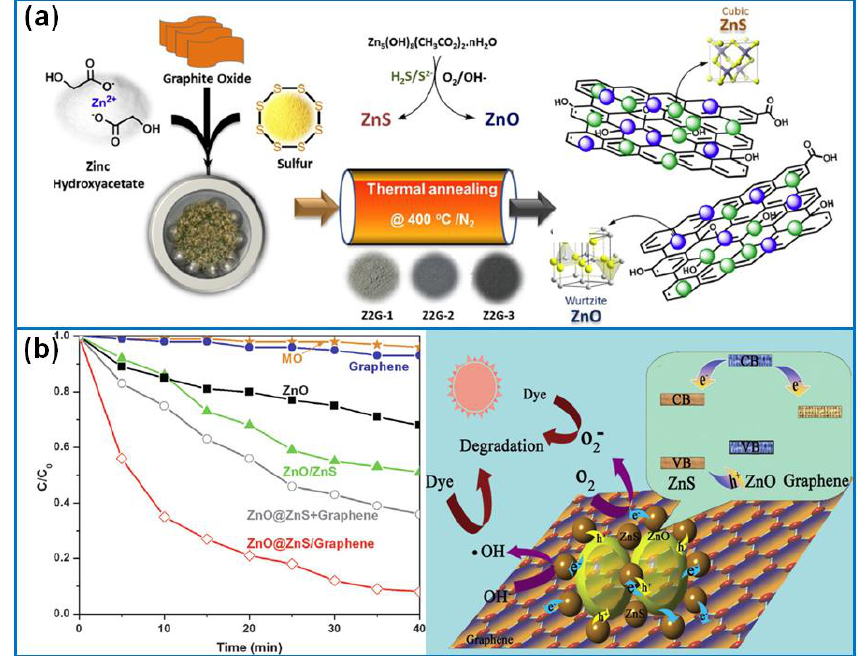
Figure 8. ( a ) Preparation of ZnS–ZnO/graphene heterostructured photocatalysts by ball milling; produced with permission [130]. ( b ) The performance of ZnO@ZnS/graphene composite and its produced with permission [130]. ( b ) The performance of ZnO@ZnS / graphene composite and photocatalytic mechanism; produced with permission [131]. Copyright 2012, Royal Society of Chemistry.